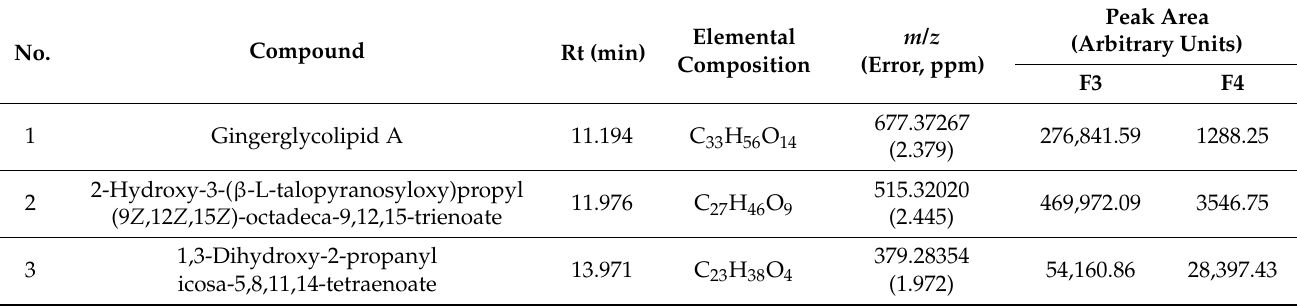
Table 4. Major non-volatile compounds in F3 and F4 fractions and their tentative identification by UHPLC-ESI(+)-HRMS.